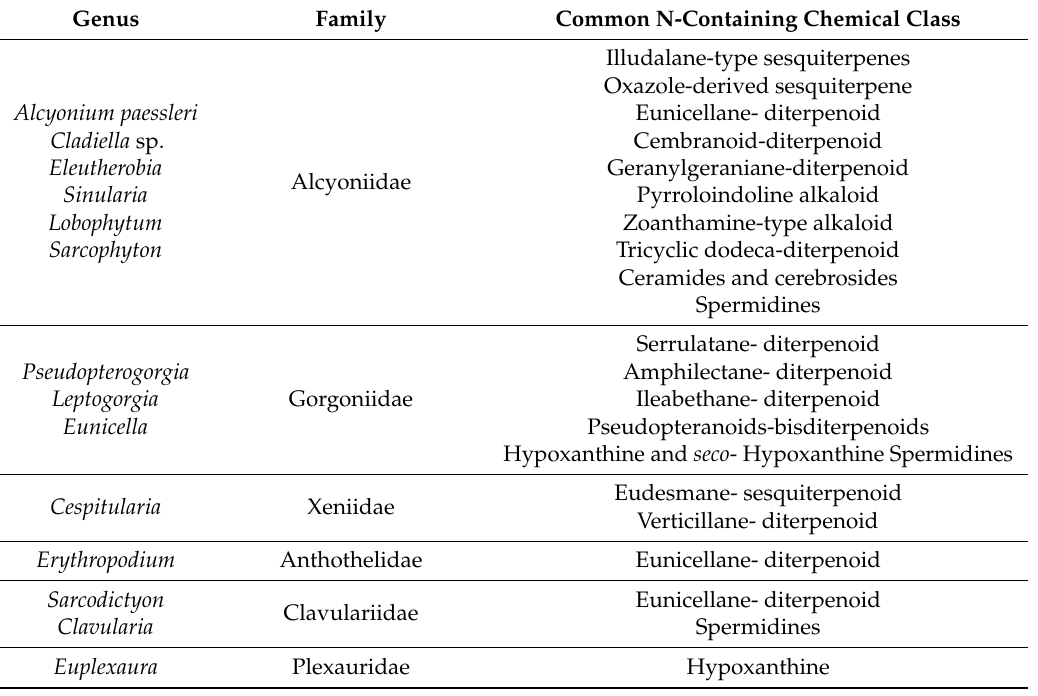
Table 3. Distribution of nitrogen-containing metabolites isolated from soft corals by genus and chemical classes.